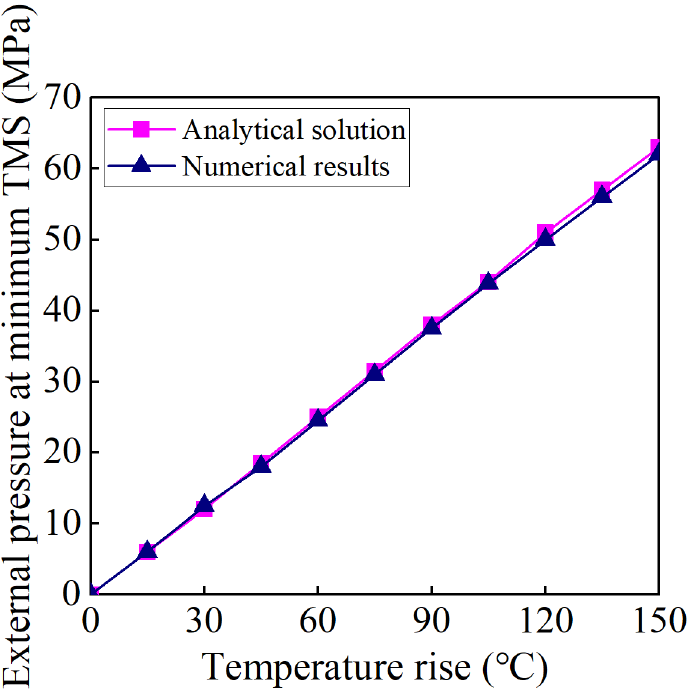
Figure 13. Comparison of analytical solution and numerical results of external pressure at the minimum TMS.